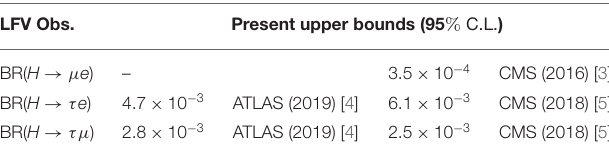
TABLE 1 | Present experimental upper bounds on lepton flavor violating Higgs boson decays. LFV Obs. Present upper bounds (95 % C.L.